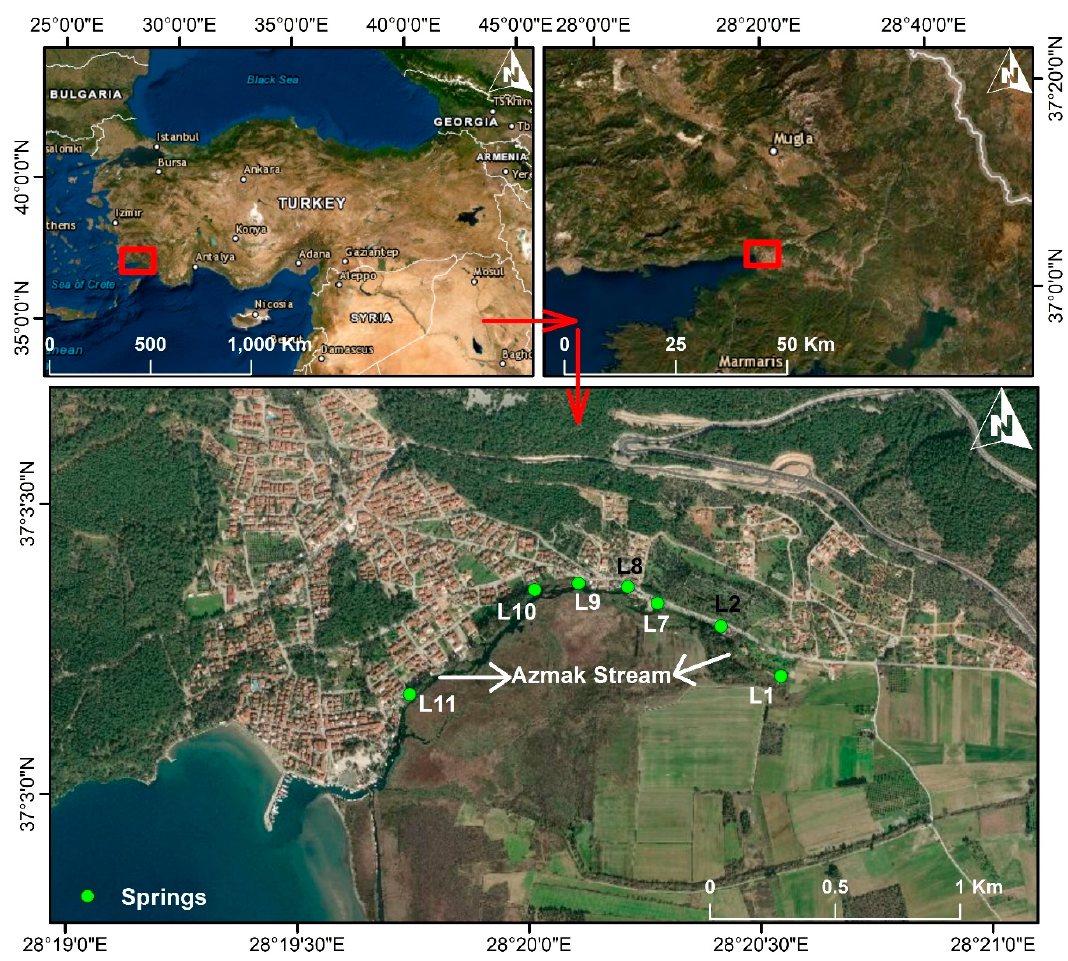
Figure 1. Location map of the springs and the Azmak Stream.